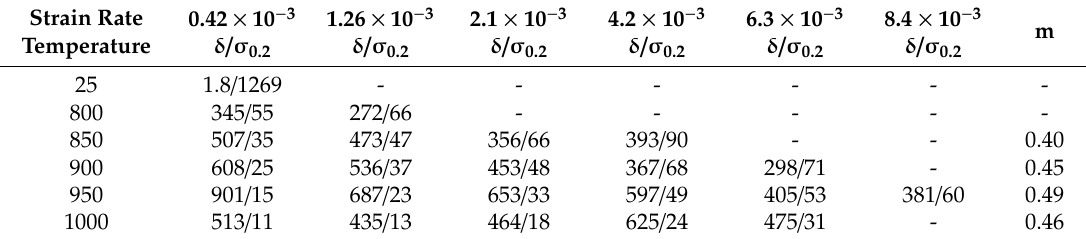
◦ C and initial strain rate 4.2 × 10